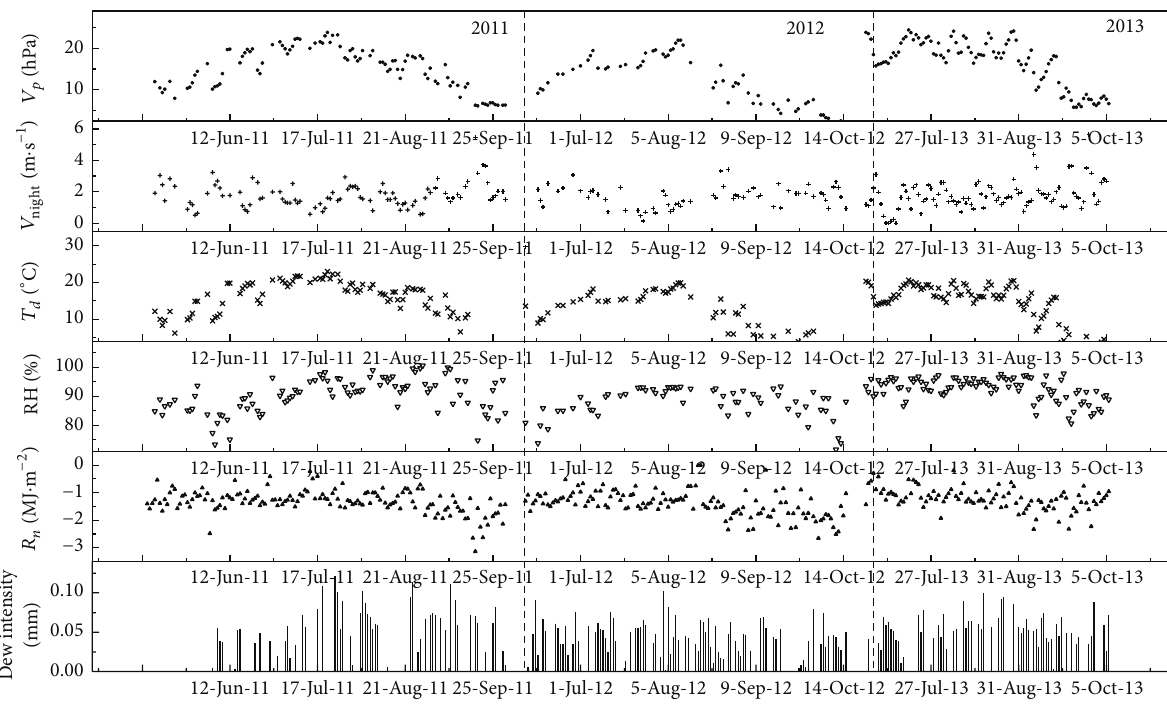
Figure 2: Variation of dew-related meteorological factors in the dew days during the experimental period.